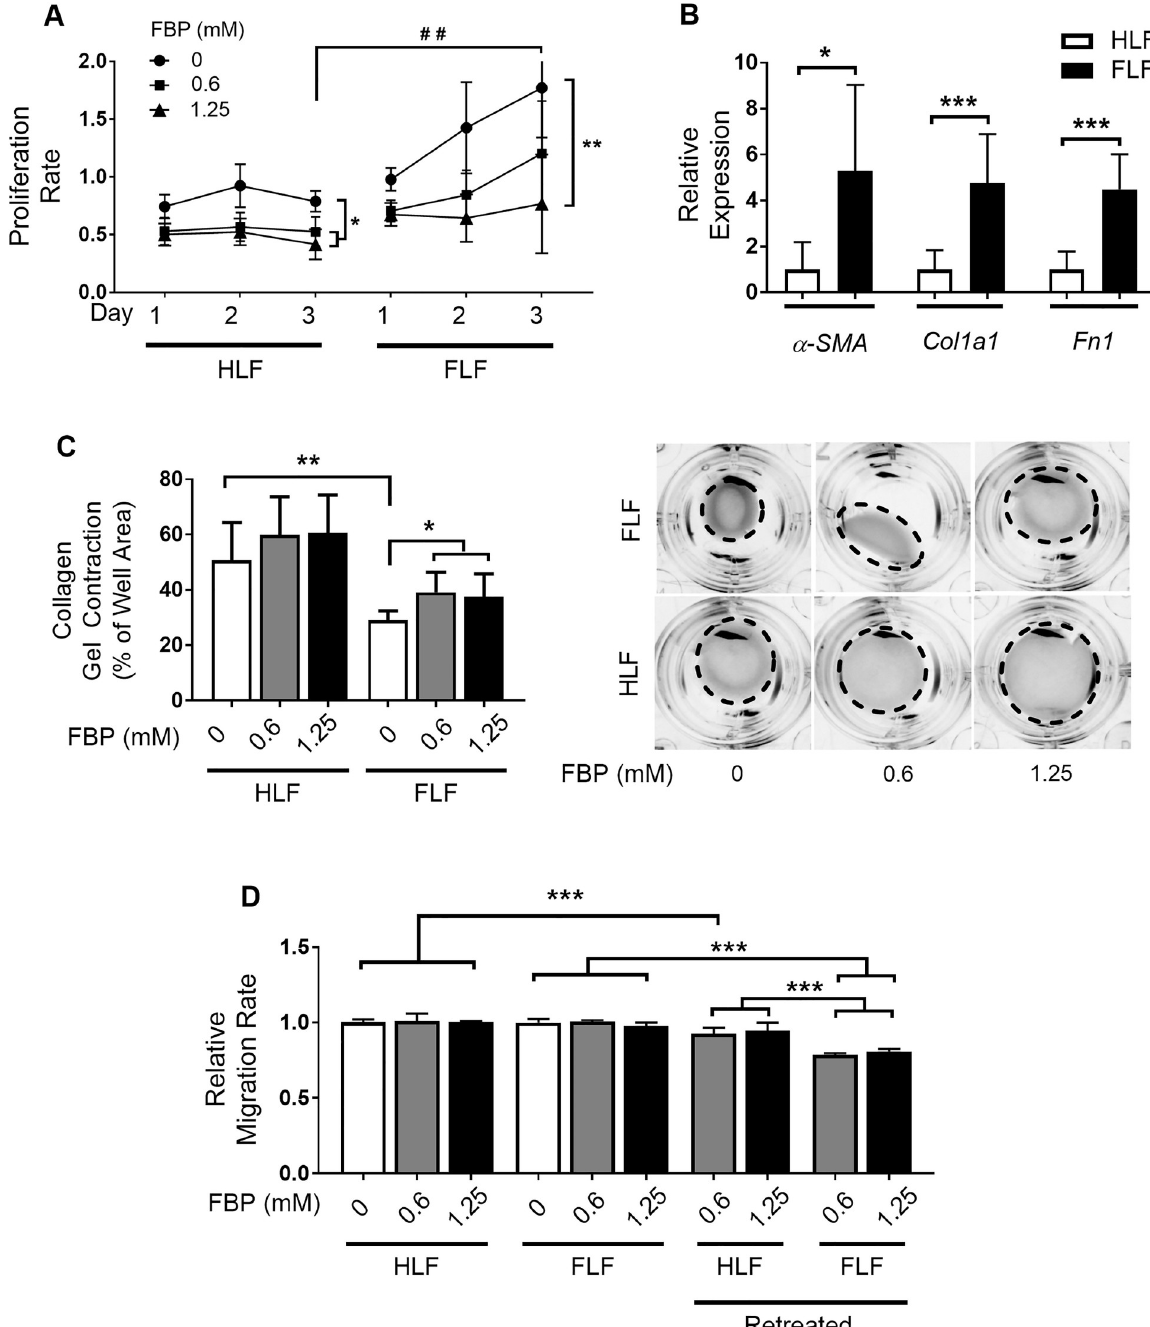
Fig 4. Fructose-1,6-bisphosphate induces non-activated phenotype in fibroblasts. (A) Cell growth. Cells were treated with 0, 0.6, and 1.25 mM FBP and proliferation rate of fibroblasts from healthy (HLF) and fibrotic (FLF) lungs was assessed in 1, 2, and 3 days after treatment. Y axis shows the absorbance of CCK8 assay. (B) Comparison of ECM components gene expression between cells extracted from healthy (HLF) and fibrotic (FLF) lung tissues. (C) Cell contraction analysis in collagen gel. Cells were embedded in a collagen solution and allowed to polymerize to form a gel. The gel was detached from the well and treated with different concentrations of FBP. Results are expressed as a percentage of well area occupied by the gel after a 24 h of incubation based on the size of empty well considered as 100%. Representative images used for the analysis are shown on the right. Dashed line shows the outline of the contracted gels after 24 h. (D) Cell migration assay. Cells were treated with FBP (0.6 or 1.25mM) for 3 days, detached and seeded inside an insert with 1% FBS RPMI-1640. The insert was placed inside a well of a 24-well plate with 20% FBS as chemoattractant and the invasion migration was assessed 24 h later. For retreatment, fresh FBP solution was added to the cells inside the insert (1% FBS RPMI-1640 + 0.6 or 1.25 mM FBP). The relative migration rate for all groups was calculated considering the migration values